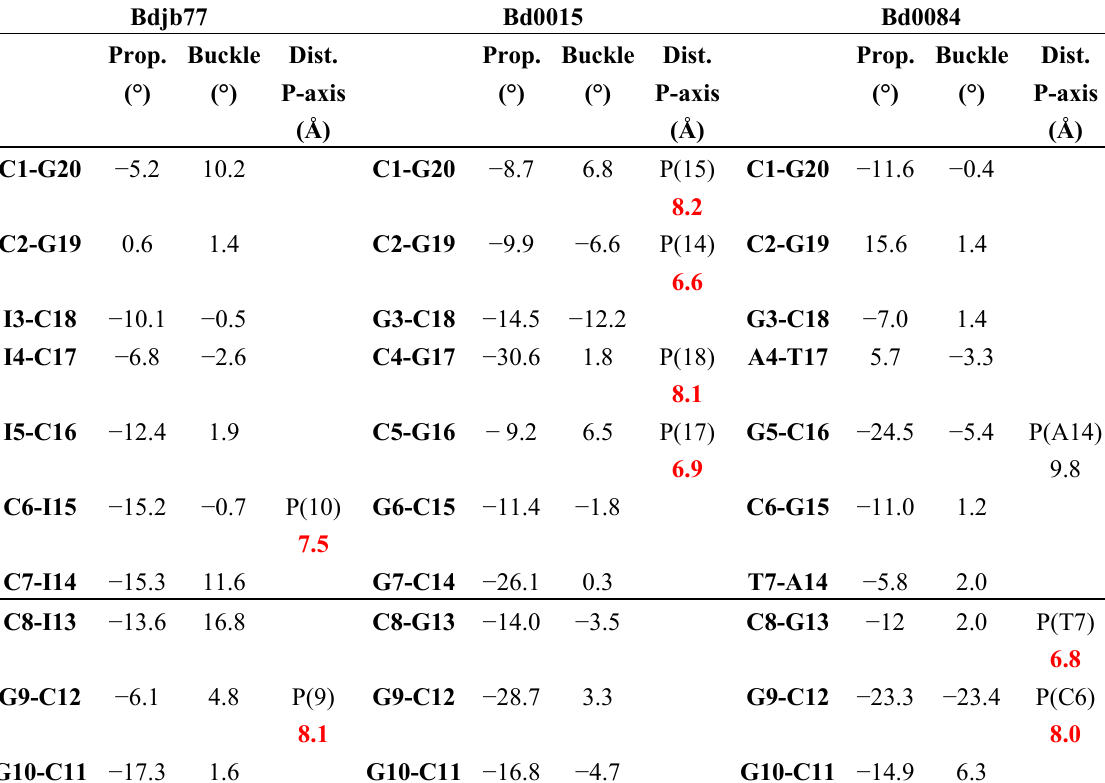
Table 1. Base stacking alterations induced by DNA-DNA interactions. The distances between the phosphorus atoms of the symmetry related molecules and the helical axis, in front of the corresponding base-pairs are written in